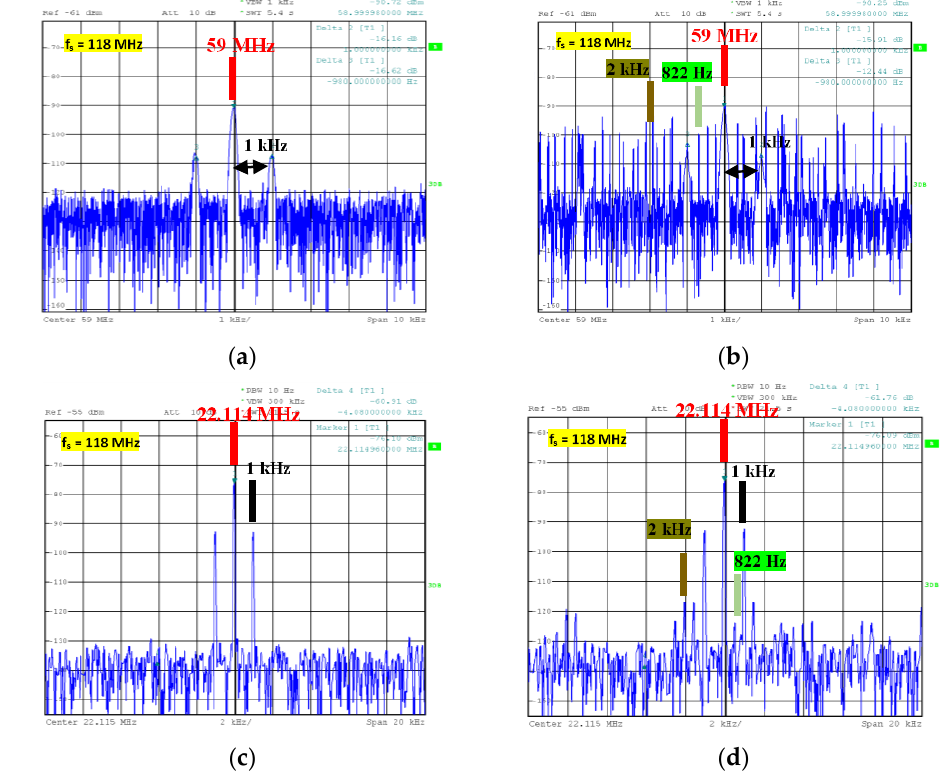
Figure 20. Resulting frequency spectrum for case of ½ f s , ( a ) single amplitude modulation (AM) signal, ( b ) AM signal when DC-DC power converter is active, ( c ) single AM signal image frequency rejection, ( d ) DC-DC converter image frequency rejection.